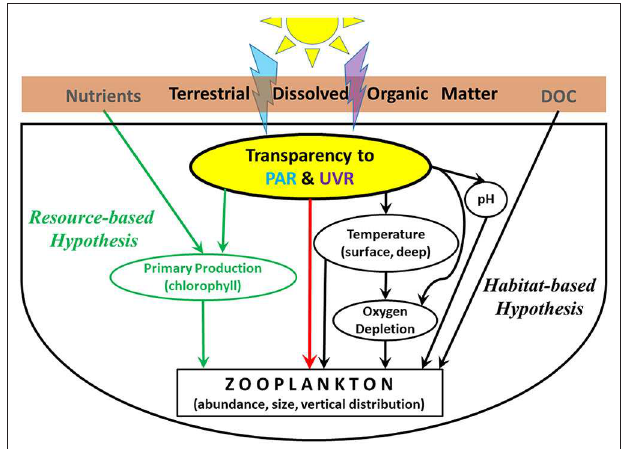
FIGURE 1 | Conceptual model of how DOM alters the underwater light environment to influence not only resources relevant to the resource-based hypothesis (green), but also many aspects of the pelagic habitat for zooplankton (black). Direct effects of PAR and UVR (e.g., vertical migration, DNA damage) are shown in